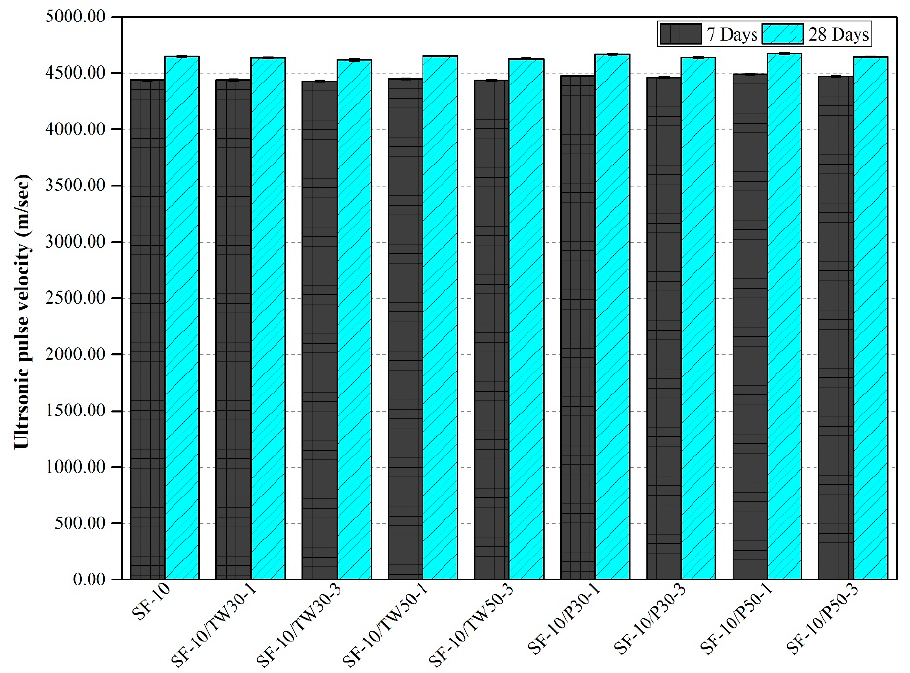
Figure 8. Ultrasonic pulse velocity of mortars made with tea waste and perlite particles with 10% SF.